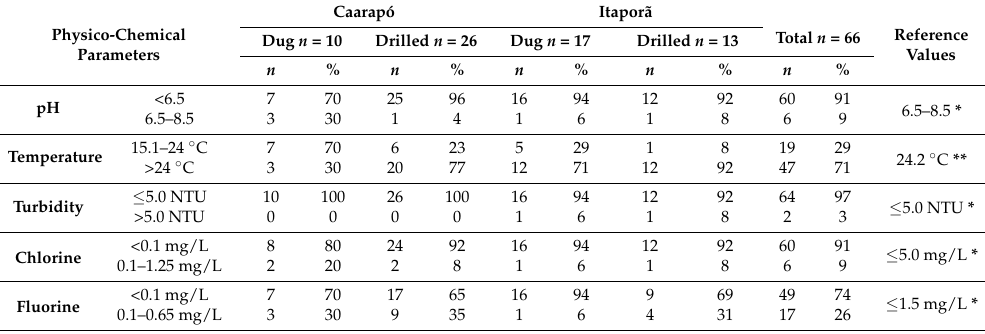
Table 1. Physico-chemical parameters of groundwater from private wells in the cities of Caarapó and Itaporã, MS, Brazil (2014).